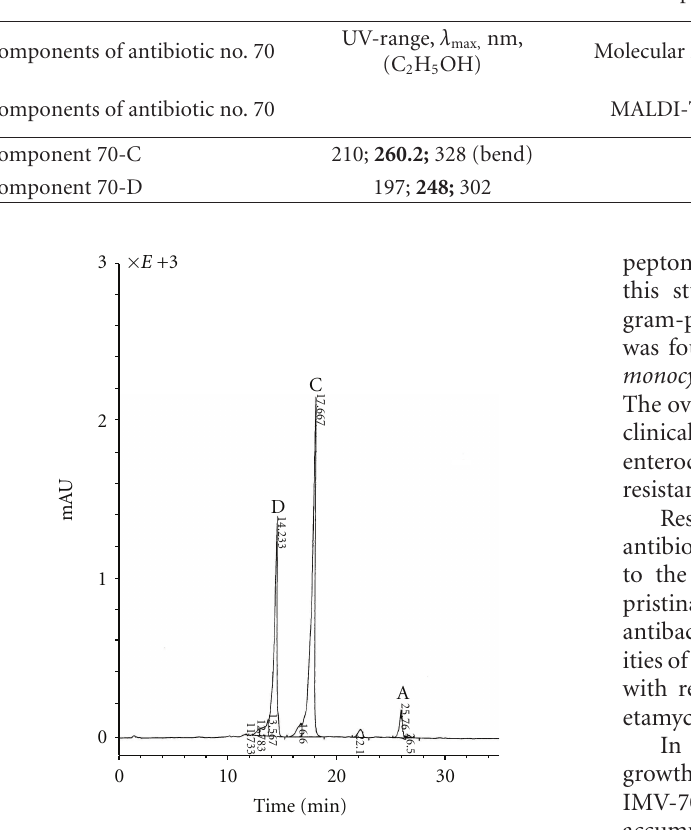
Figure 3: Chromatogram of antibiotic compound no. 70, formed in medium A with soy flour . The antibiotic compounds with a higher ratio of minor components and lower ratio of the main component A are formed on medium A with soy flour, in contrast to the medium containing yeast extract, whereby component A makes up to 74% of total compounds (as shown in Figure 2). Figure 3 shows the chromatogram of the main component of compound no. 70 formed in medium A with soy